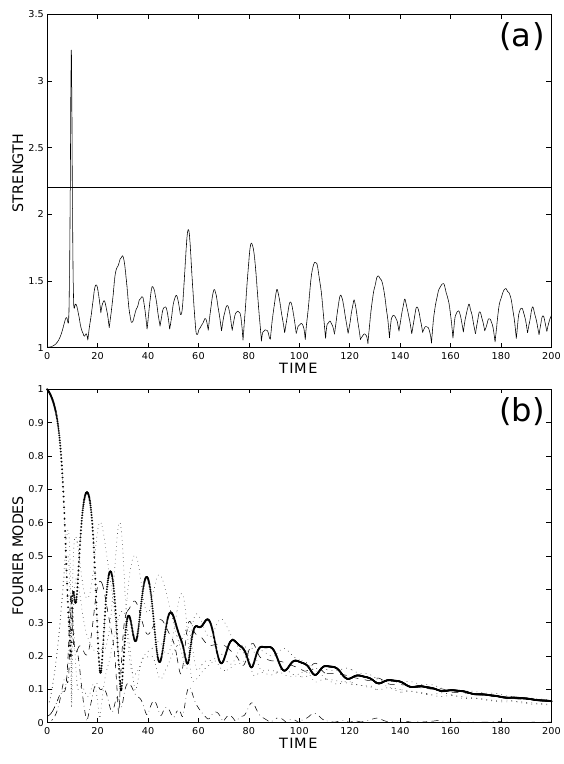
Fig. 7: The HONLS eq. with linear damping: Γ = 0 . 01 , ǫ = Fig. 7. The HONLS eq. with linear damping: 0 = 0 . 01, (cid:15) = 0 . 05, β = 0. The time evolution of (a) the strength S(t) (b) the main 0 . 05 , β = 0 . The time evolution of (a) the strength S ( t ) (b) Fourier modes, 0 <t < 200. the main Fourier modes, 0 < t < 200 .